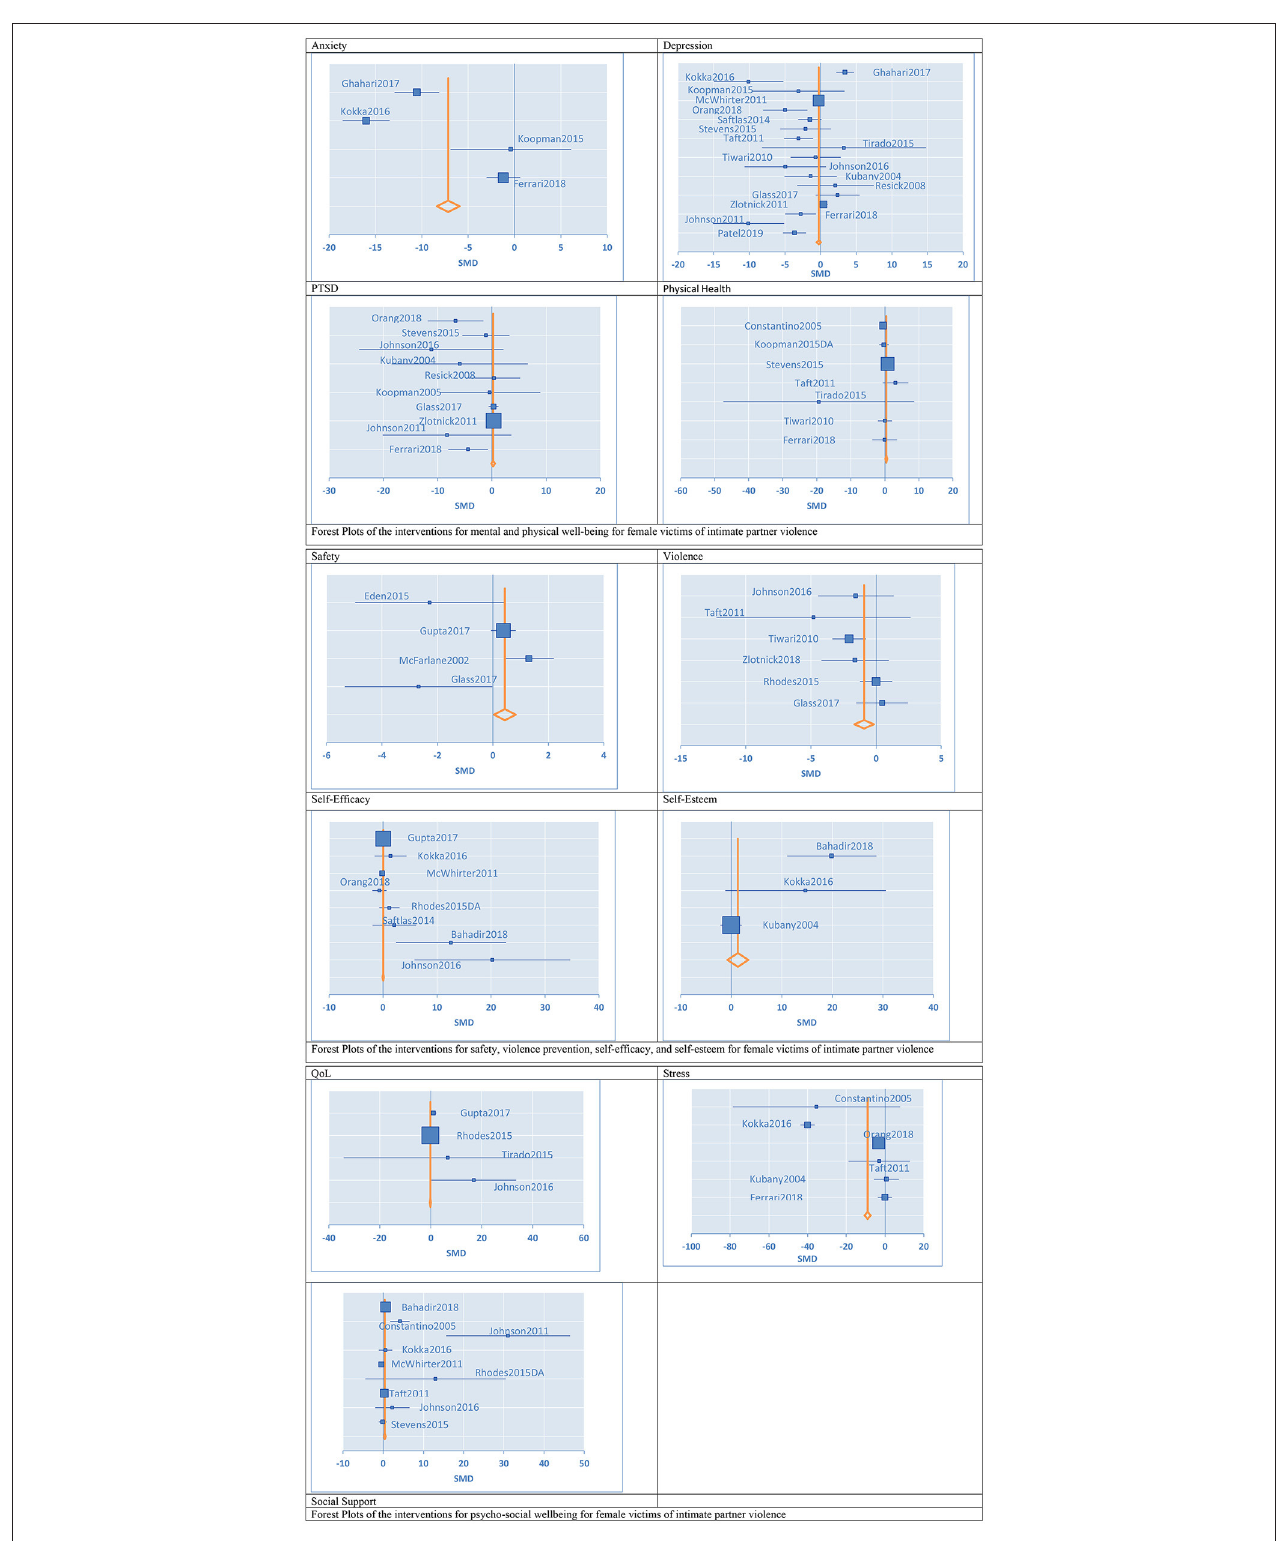
FIGURE 3 | Forest plots of the confidence interval and effect sizes of the interventions for female victims of intimate partner violence.